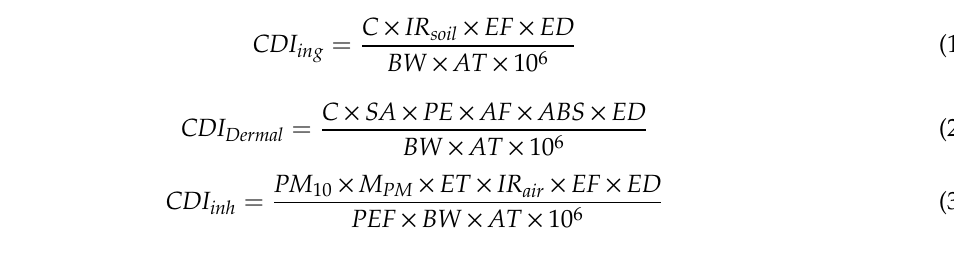
Table 2. The meaning of each exposure assessment parameter and its specific